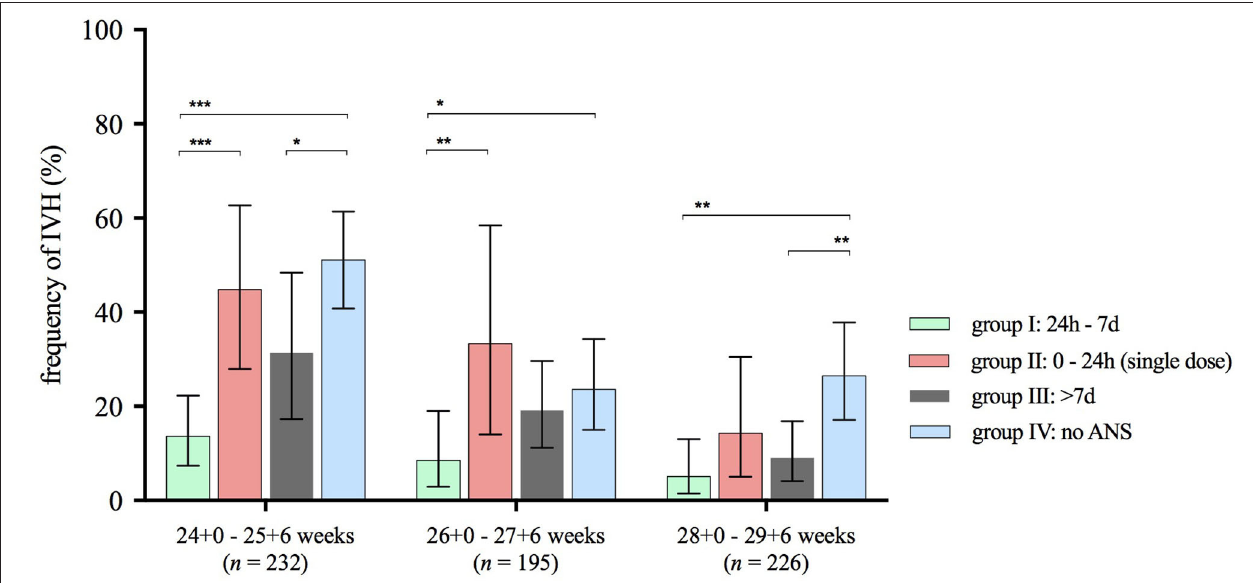
FIGURE 2 | Frequency of IVH stratified to ANS exposure groups and gestational age subgroups. ANS, antenatal steroids; IVH, intraventricular hemorrhage. Horizontal lines connect subgroups with significant differences; * p < 0.05, ** p < 0.01, *** p < 0.001; error bars show 95% confidence intervals. Number n represents the size of analyzed subcohort in respective gestational age